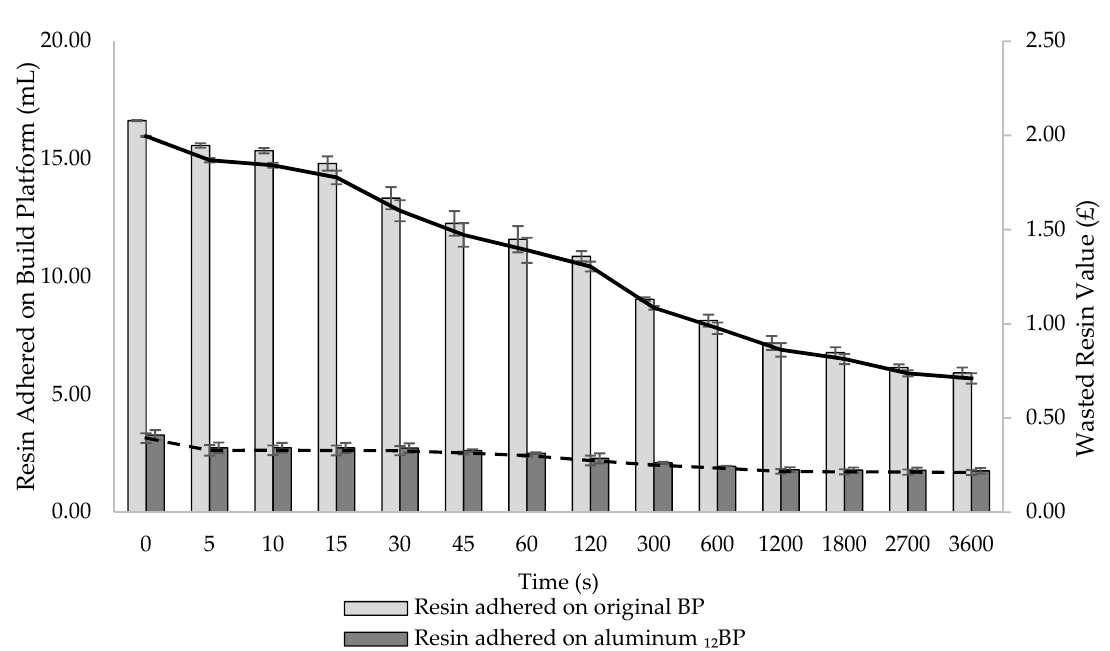
Figure 11. Comparison of photopolymer resin waste generated by adherence onto the original BP and the aluminum 12 BP over a period of one hour. The straight curve indicates the economic loss using the original SLA apparatus. The dashed curve indicates the economic loss using the modified SLA apparatus. Error bars indicate standard deviation of the measurements ( n = 3).